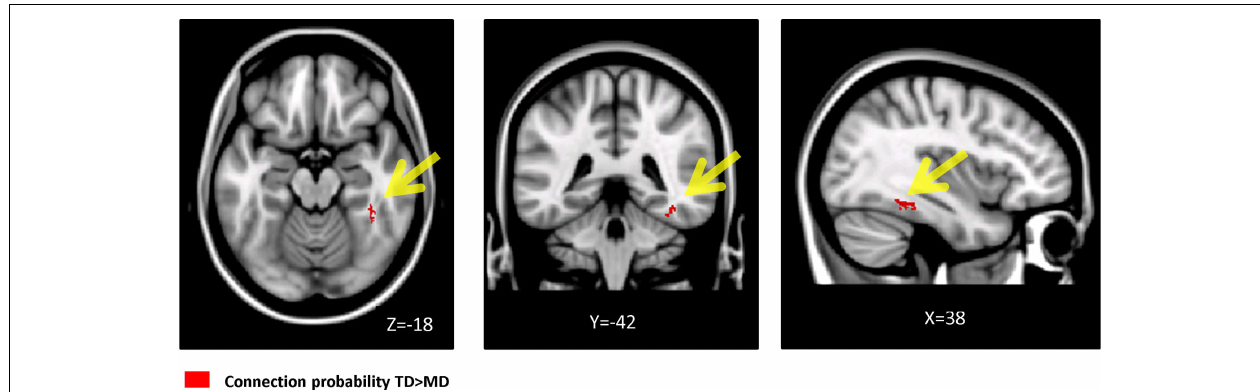
FIGURE 6 | The fusiform gyrus showed signifi cantly reduced connection probability in children with DD. Results of probabilistic tractography from right temporal-parietal WM regions that showed defi cits in children with DD as